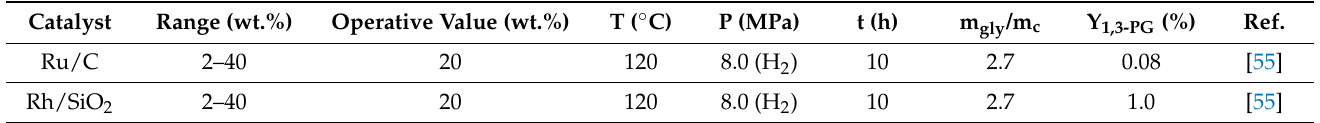
Table 7. The effect of glycerol concentration in the liquid phase using batch reactors. Catalyst Range